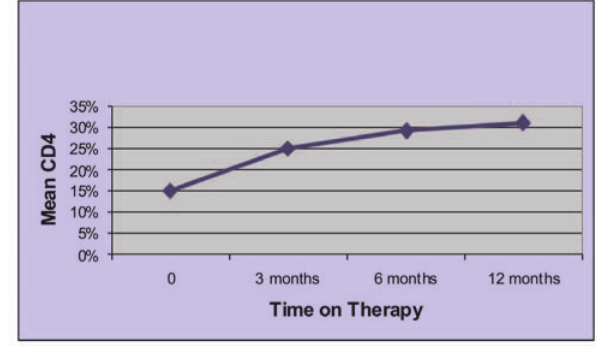
Fig. 3. Mean CD4% during first year of